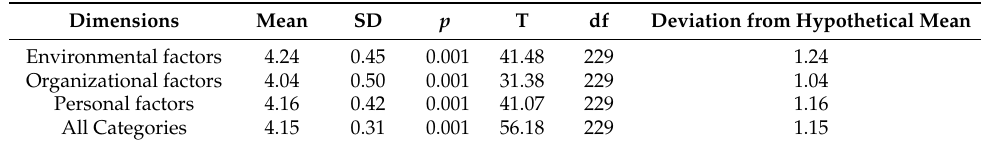
Table 2. Univariate t -test for the mean score of the factors affecting nursing compliance with the use of PPE (cut off point =